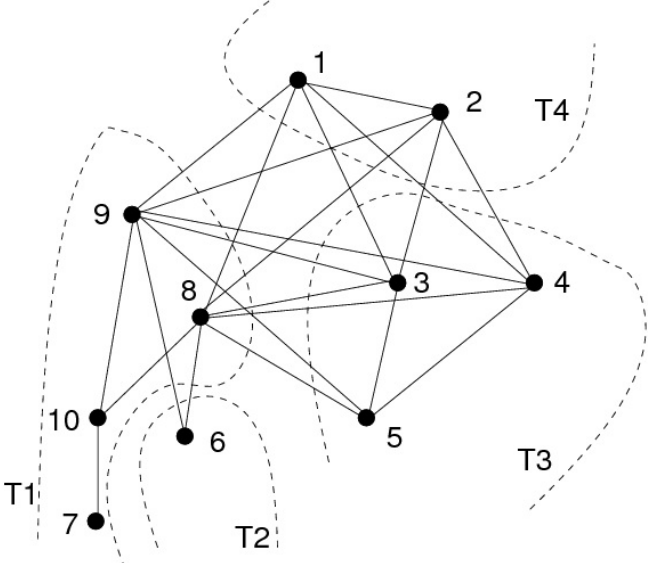
Figure 9 . The thin slices defined by the LexBFS execution on a non-chordal graph from Figure